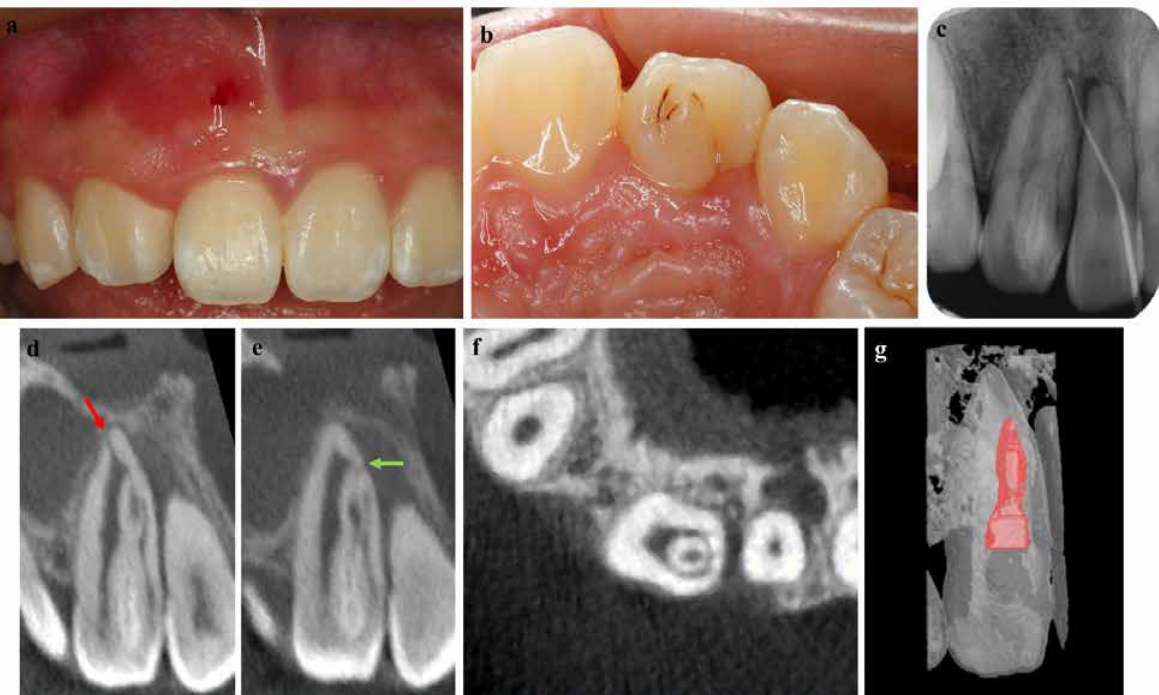
Figure 1: (a) Sinus tract with respect to tooth #8. (b) Unusual prominent lingual cusp and a deep lingual pit with respect tooth #7. (c) IOPA showing the sinus tract done by GP cone confirming the lesion on tooth#7. (d) CBCT image of the invaginated structure showing the main apical foramen (red arrow). (e)Axial view of CBCT image showing the invaginated with separate portal exit(green exit). (f) Axial view of CBCT showing the invaginated structure. (g) CBCT 3D reconstruction images demonstrating the invaginated